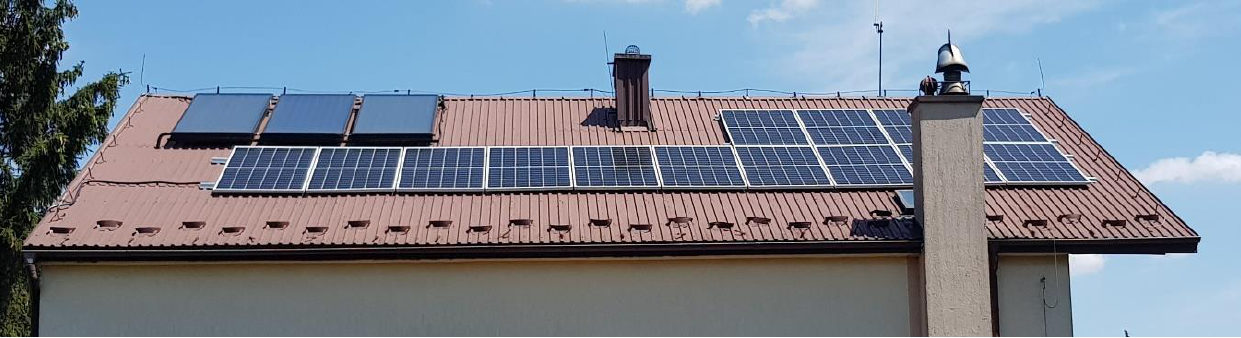
Figure 6. Panels on the roof of a single-family building in Leki.